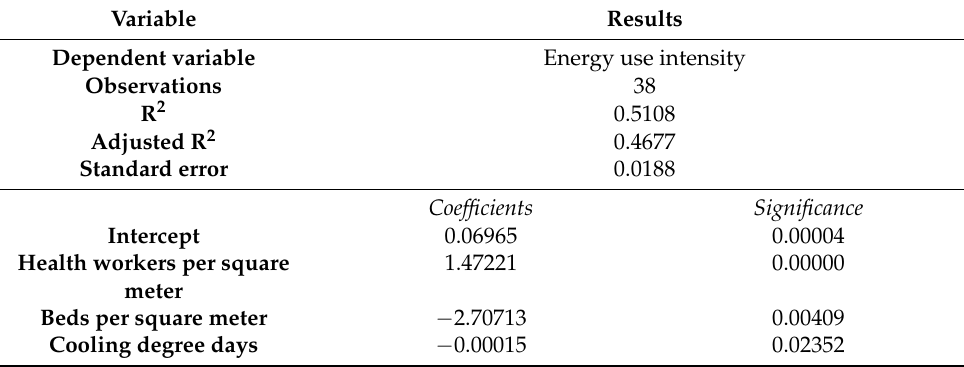
Table 5. Regression analysis results for Energy Use